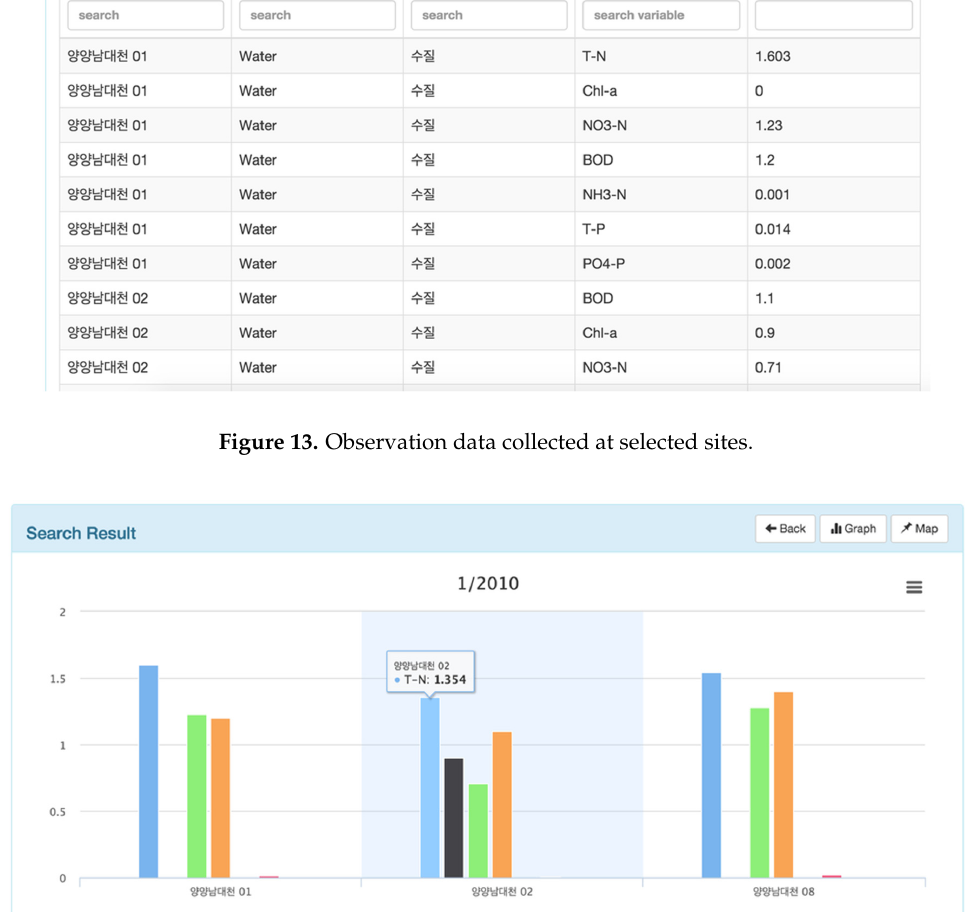
Figure 14. Observation data in the chart window.